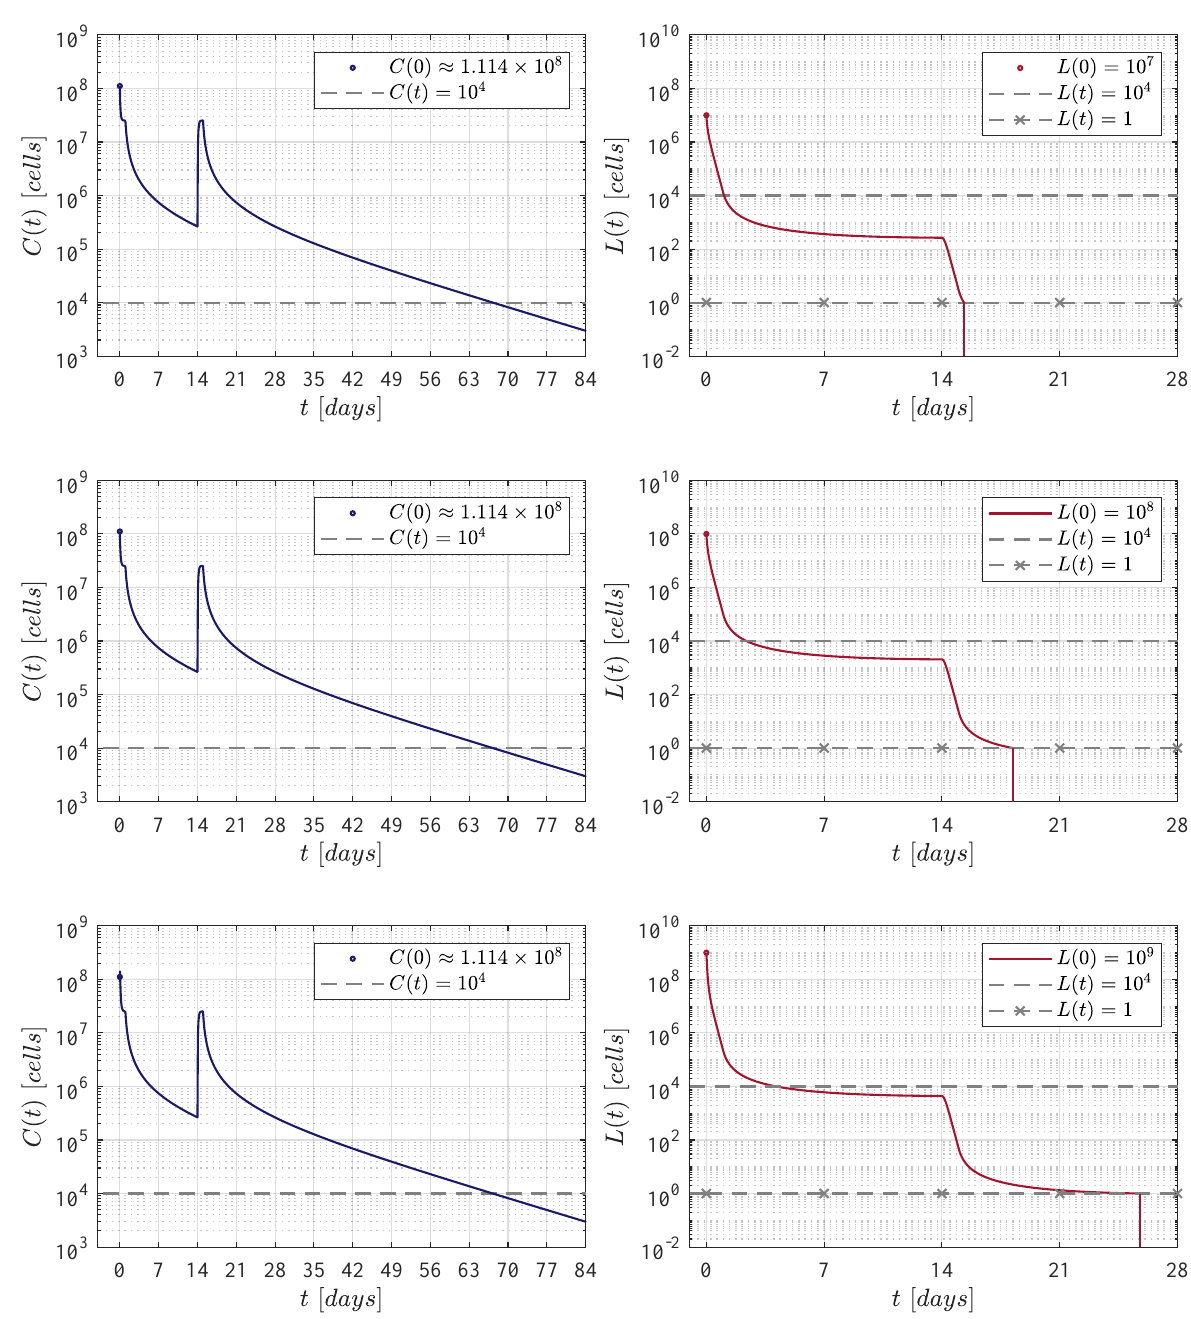
Figure 3. The fortnight administration protocol. Two applications were applied, the first one at day 0 and the second at day 14. In silico experimentations allow us to determine that in this approach a dose of 111, 337, 711 CAR-T cells was needed to achieve CR by day